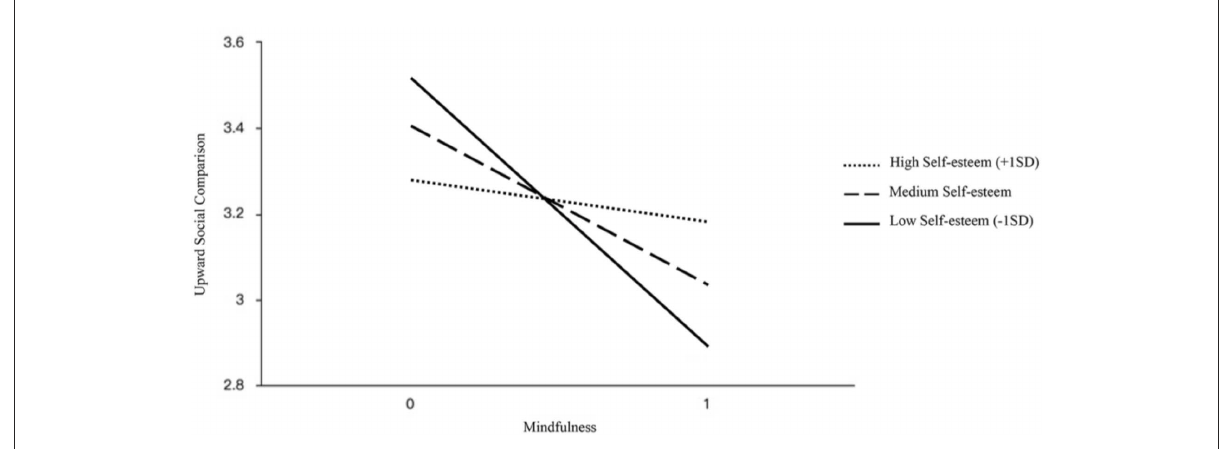
FIGURE2 Interaction between mindfulness and self-esteem on the USC is tested by a simple slope